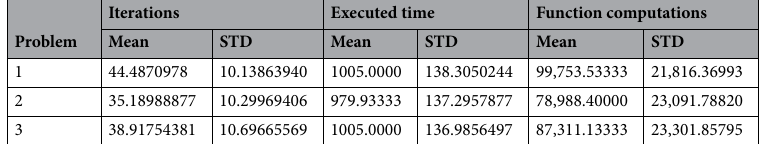
Table 5. Complexity performances for each case of the for solving the novel SO-PSDDM.